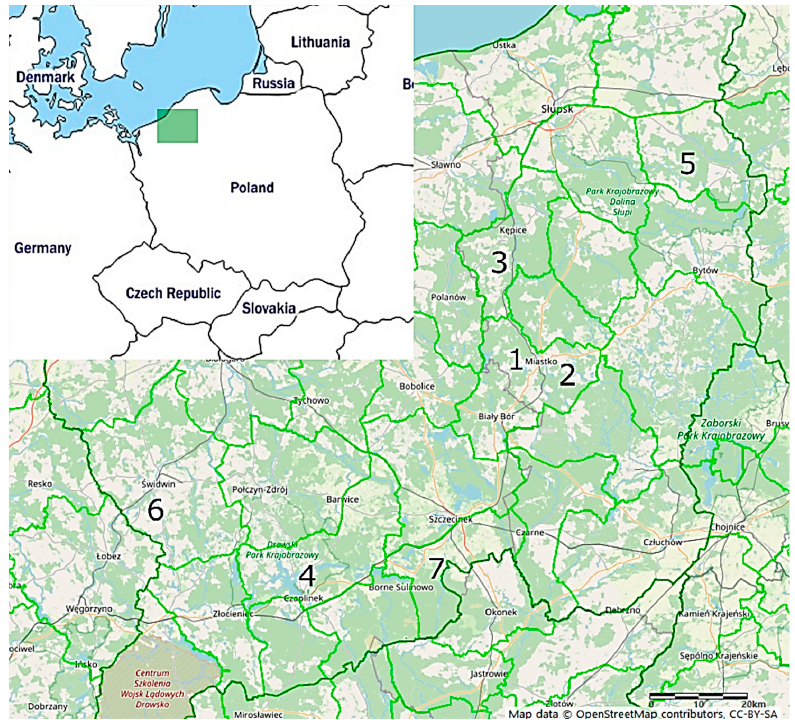
Figure 1. Location of the study (number explanation in Table 1).